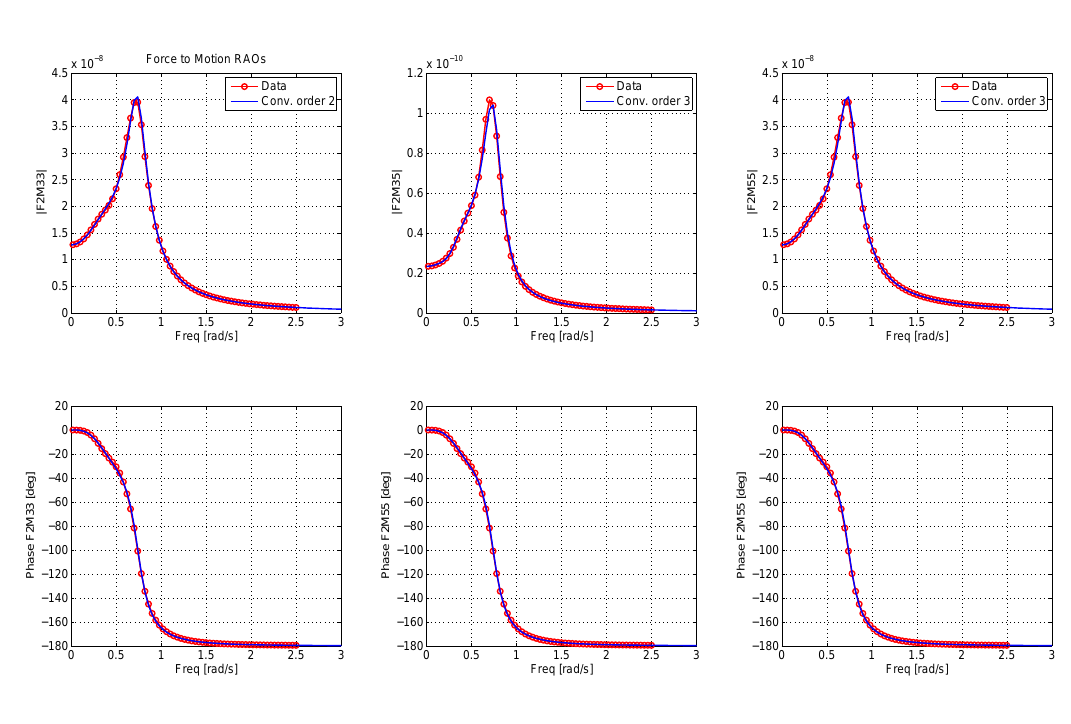
Figure 14: Force-to-displacement frequency response functions: non-parametric, and parametric based on Re- alization Theory.